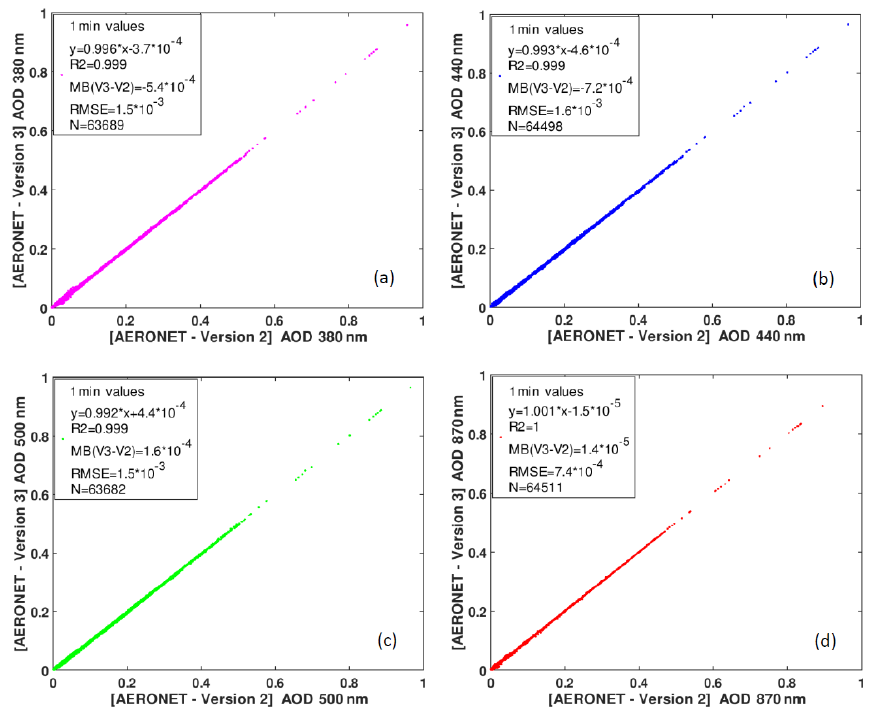
Figure 1. AERONET version 3 (V3) versus version 2 (V2) AOD 1min data scatterplot at Izaña Observatory for the period 2005–2015: (a) 380nm, (b) 440nm, (c) 500nm and (d) 870nm. The corresponding equations of the linear fits, the coefficients of determination ( R 2 ), mean bias (MB), root-mean-square error (RMSE) and the number of data pairs ( N ) used are included in each legend.